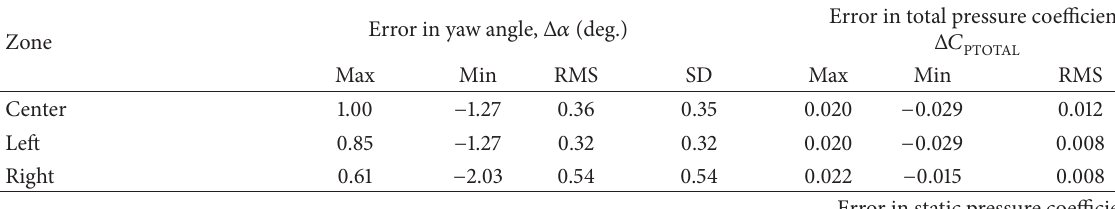
Table 2: Errors in yaw and pitch angles and total and static pressure